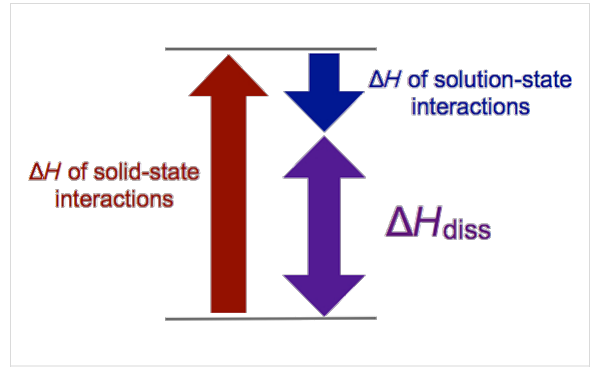
Figure 4: Relationship between dissolution enthalpies and intermolec- ular interactions. Gelators exhibit (on average) larger Δ H diss than nongelators, suggesting stronger solid-state interactions and weaker solvent